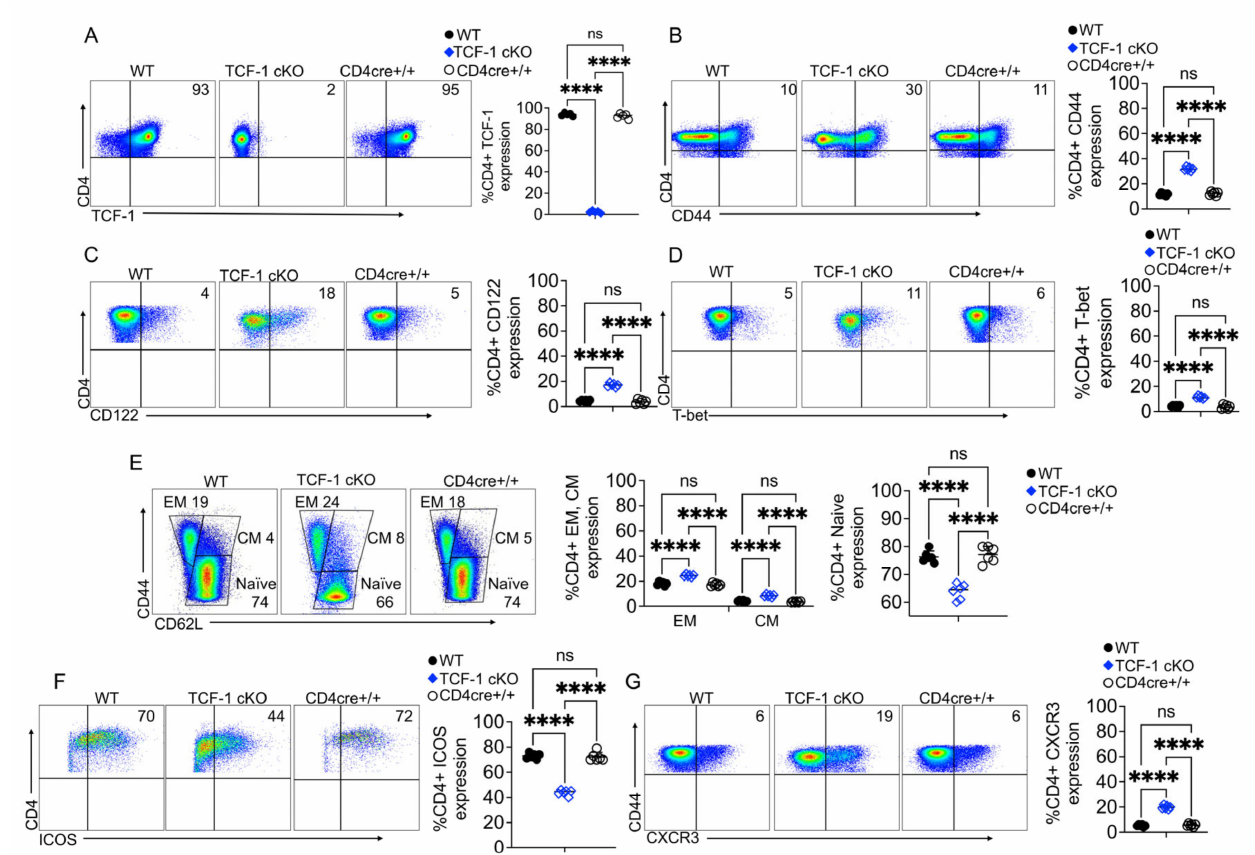
Figure 1. TCF-1 regulates CD4 T cell phenotypes and memory formation. ( A – G ) Splenocytes from WT, CD4cre+/+ or TCF-1 cKO donor mice were isolated, and stained for flow cytometry, and run on a BD LSRFortessa flow cytometer. ( A ) Flow plot of CD4 T cells expressing TCF-1 and statistical analysis of the percent of CD4 T cells expressing TCF-1 with a quantitative analysis. ( B ) Flow plot of CD4 T cells expressing CD44 and a statistical analysis of the percent of CD4 T cells expressing CD44 with a quantitative analysis graph. ( C ) Flow plot of CD4 T cells expressing CD122 and a statistical analysis of the percent of CD4 T cells expressing CD122 with a quantitative analysis graph. ( D ) Flow plot of CD4 T cells expressing T-bet and a statistical analysis of the percent of CD4 T cells expressing T-bet. Quantitative analysis of several mice presented as a graph. ( E ) Flow plot of the memory phenotype of CD4 T cells by expression of CD44 and CD62L and a statistical analysis of the percent of CD4 T cells with memory phenotypes. Quantitative analysis of several mice presented as a graph. ( F ) Flow plot of effector memory CD4 T cells expressing ICOS and a statistical analysis of the percent of the effector memory CD4 T cells expressing ICOS. ( G ) Flow plot of CD4 T cells expressing CXCR3 and a statistical analysis of the percent of CD4 T cells expressing CXCR3. All data are shown as individual points with mean and SD, all data were analyzed with Student’s t -test or one-way ANOVA (depending on data groups) followed by Tukey’s multiple comparisons. For naïve mice n = 3–5 per group of mice are shown. For chimeric mice n = 5 per group of mice and one experiment is shown (carried out once). **** means p -value ≤